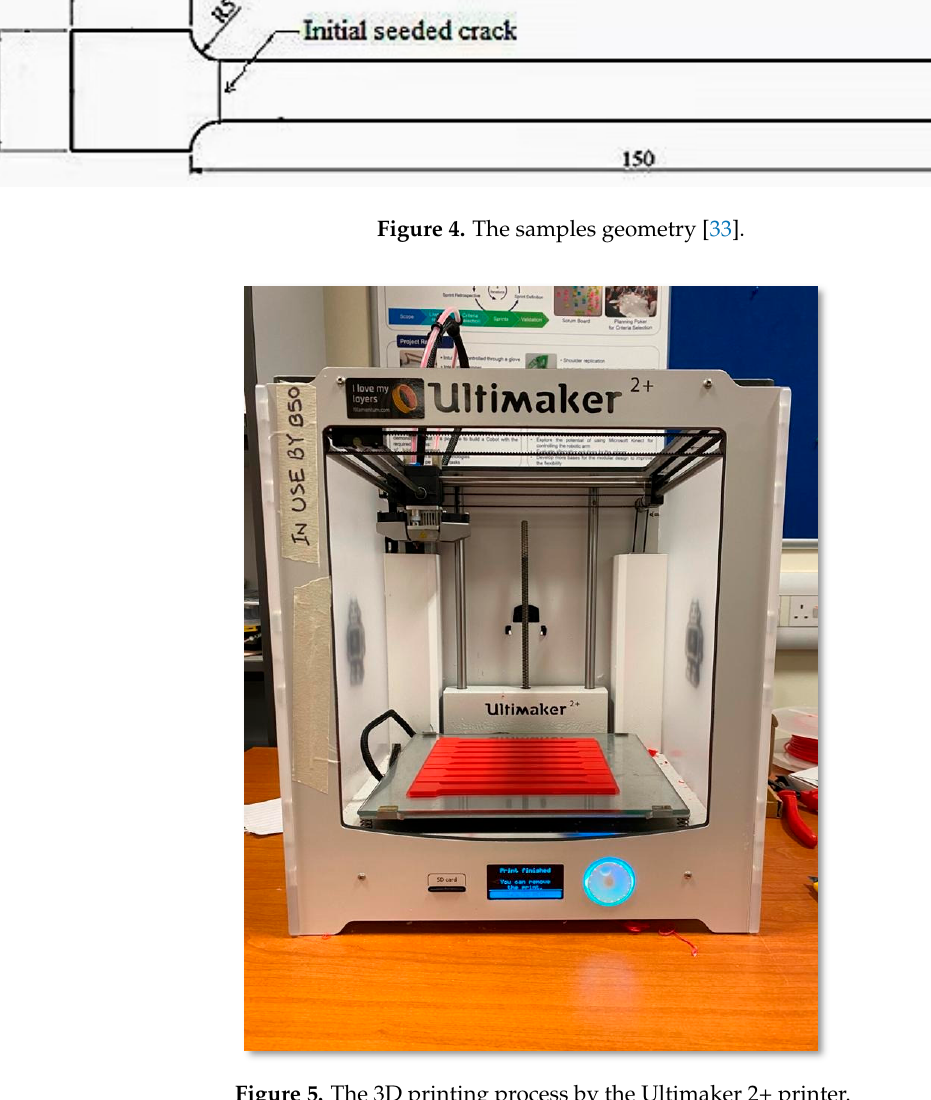
Figure 4. The samples geometry [33].